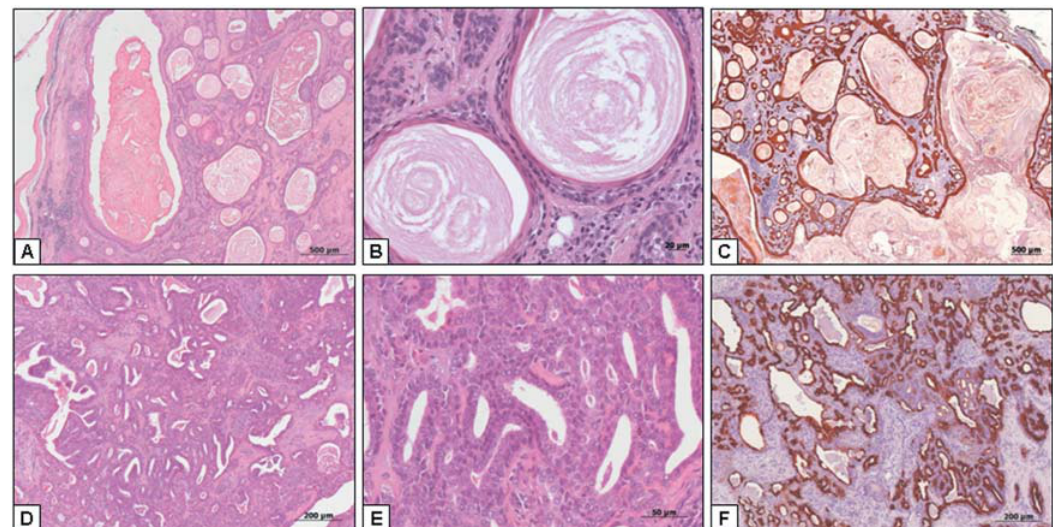
Figure 2- (cid:2)(cid:3)(cid:4)(cid:5)(cid:6)(cid:7)(cid:8)(cid:9)(cid:10)(cid:6)(cid:11)(cid:12)(cid:13)(cid:2)(cid:10)(cid:12)(cid:8)(cid:14)(cid:15)(cid:4)(cid:2)(cid:5)(cid:15)(cid:16)(cid:7)(cid:15)(cid:8)(cid:12)(cid:13)(cid:2)(cid:15)(cid:17)(cid:2)(cid:16)(cid:9)(cid:10)(cid:11)(cid:14)(cid:7)(cid:10)(cid:12)(cid:2)(cid:18)(cid:12)(cid:19)(cid:6)(cid:11)(cid:14)(cid:4)(cid:2)(cid:5)(cid:20)(cid:8)(cid:11)(cid:8)(cid:2)(cid:15)(cid:17)(cid:2)(cid:21)(cid:6)(cid:19)(cid:14)(cid:6)(cid:22)(cid:10)(cid:12)(cid:2)(cid:8)(cid:14)(cid:23)(cid:12)(cid:2)(cid:24)(cid:25)(cid:26)(cid:27)(cid:2)(cid:28)(cid:20)(cid:8)(cid:11)(cid:8)(cid:2)(cid:10)(cid:14)(cid:4)(cid:12)(cid:13)(cid:2)(cid:22)(cid:20)(cid:2)(cid:8)(cid:11)(cid:19)(cid:6)(cid:11)(cid:14)(cid:29)(cid:12)(cid:13)(cid:2)(cid:8)(cid:30)(cid:9)(cid:6)(cid:16)(cid:15)(cid:9)(cid:8)(cid:2) epithelium (B), which is intensely positive for high-molecular-weight cytokeratins (CKs; C). Numerous duct-like formations (D), lined by a double layer of cells (E). Intense expression of CK7 in luminal cells of the duct-like structures (F). Hematoxylin and eosin stain (A,B,D,E). Immunoperoxidase stain (C,F)